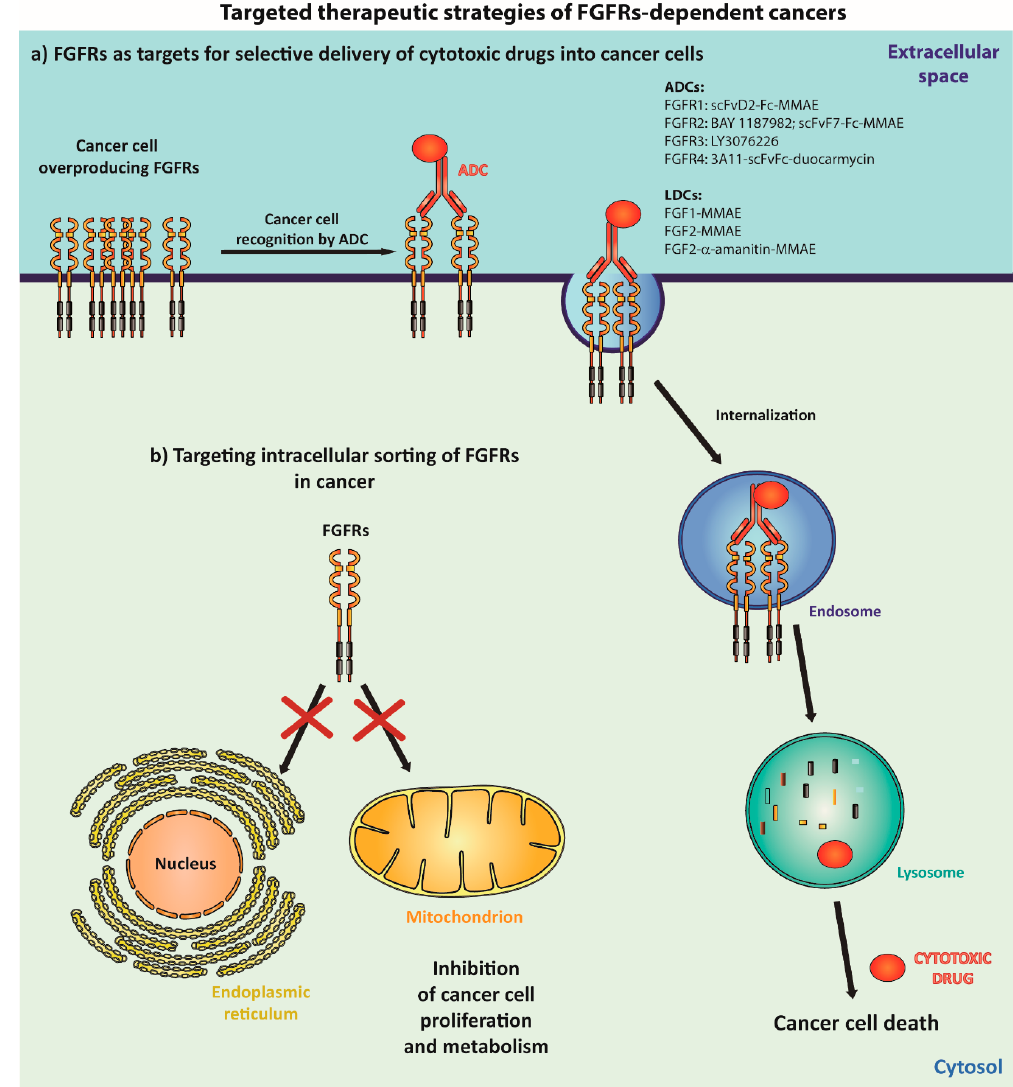
Figure 6. Employing cellular protein trafficking machineries for targeted therapeutic strategies of FGFRs-dependent cancers. Numerous cancers overproduce FGFRs on their surface. Construction of highly selective cytotoxic molecules, like antibody-drug conjugates (ADCs) or ligand drug conjugates (LDCs) allows for the specific recognition of cancer cells and for the delivery of cytotoxic agents into the cancer cell interior, resulting in cell death ( a ). FGFRs are found in the nucleus and mitochondria, where they contribute to oncogenic process. The inhibition of FGFRs transported to these organelles can block the oncogenic activity of intracellular FGFRs ( b ).